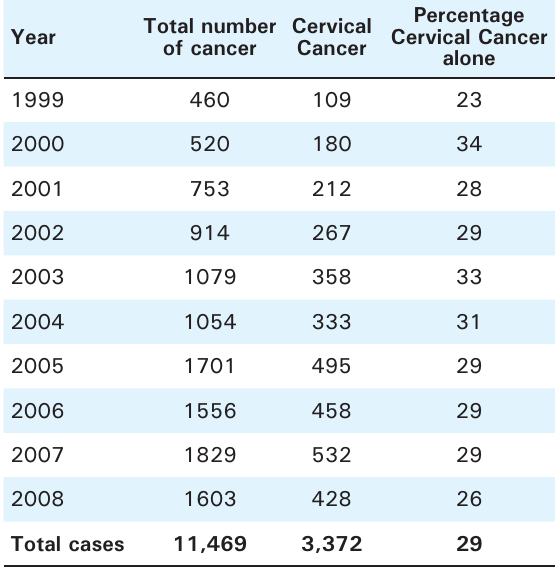
Table 1. Occurrence of Cervical Cancer among other